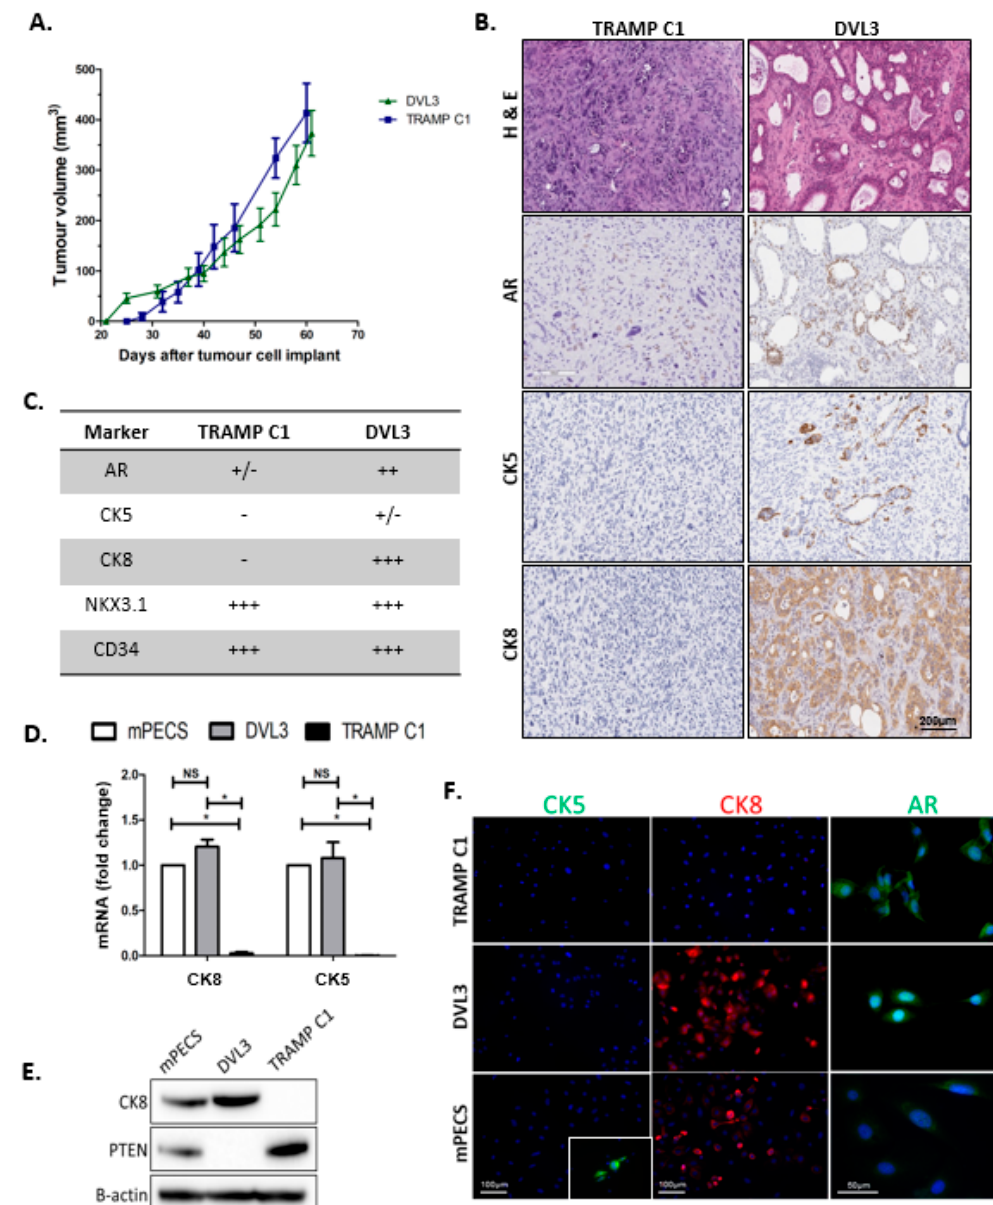
Figure 1. DVL3 syngeneic tumours replicate patient disease. ( A ) DVL3 tumour growth (green)